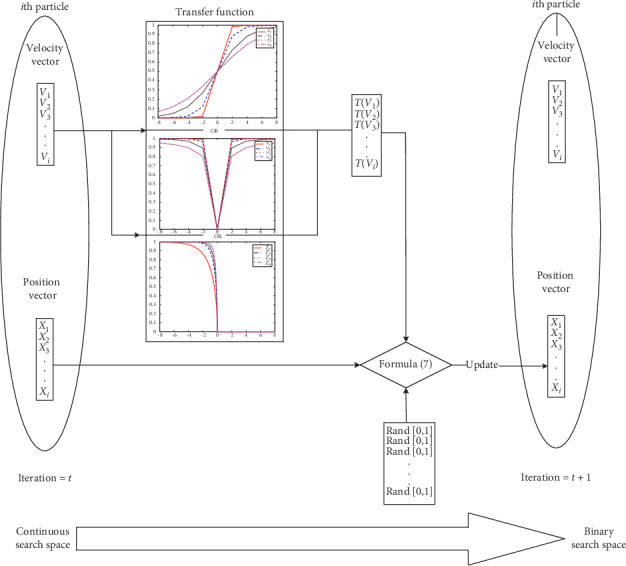
Procedure of mapping continuous search space to discrete search space.